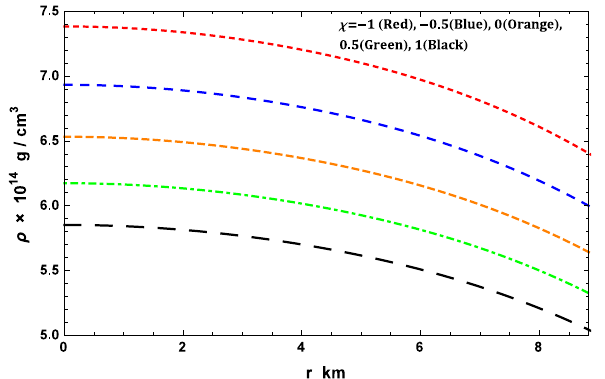
Fig. 4 Anisotropy profile of SMC X-4 for M = 1 . 29 M (cid:9) , R = 8 . 831 km and b = 0 . 0031km − 2